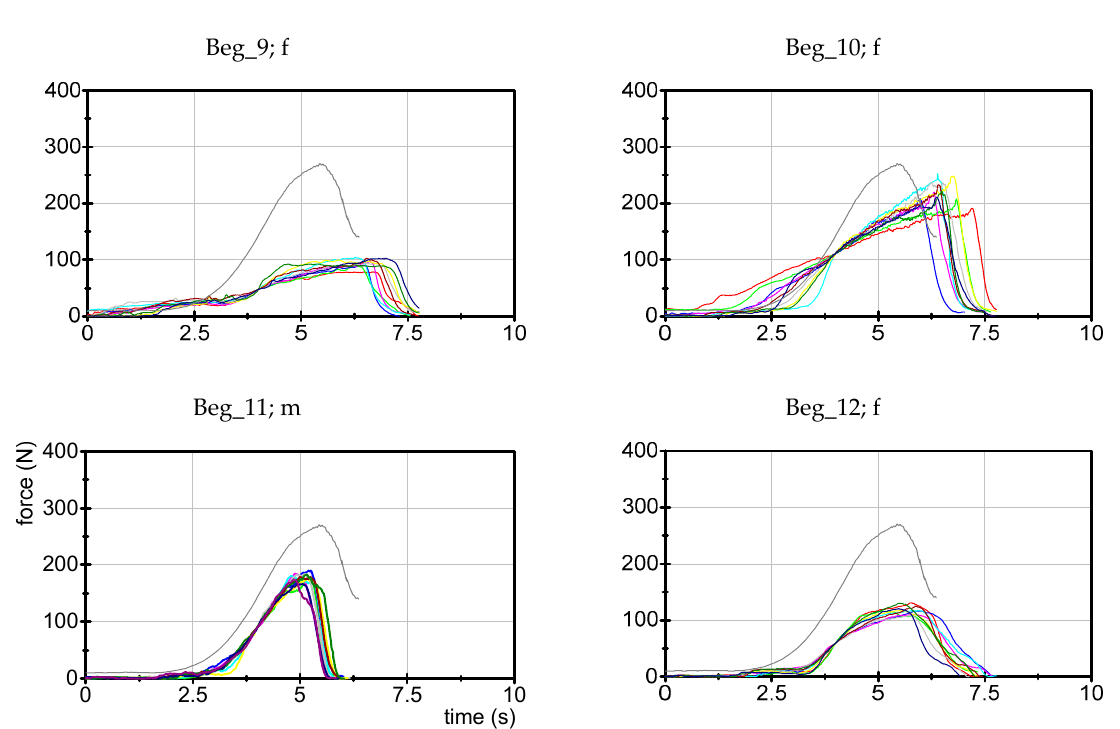
Figure 5. Force profiles of Beginners. Displayed are the 10 individual force profiles of the n = 12 beginners (Beg). The grey curve displays the suggestion of a standardized force profile (see discussion). To have a better comparison, the x - and y -axes are standardized (0–10 s and 0–400 N). The ID (Beg_no.) and gender (f = female, m = male) are given per tester. The years of experience for each tester is zero.